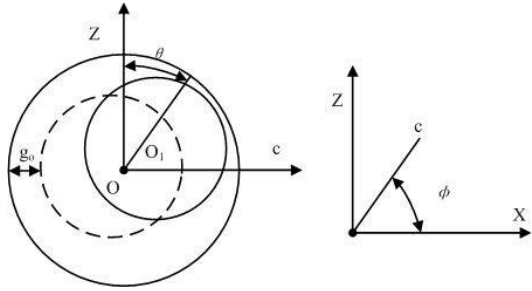
Figure 22. Projection at the center of the rotor in any plane.